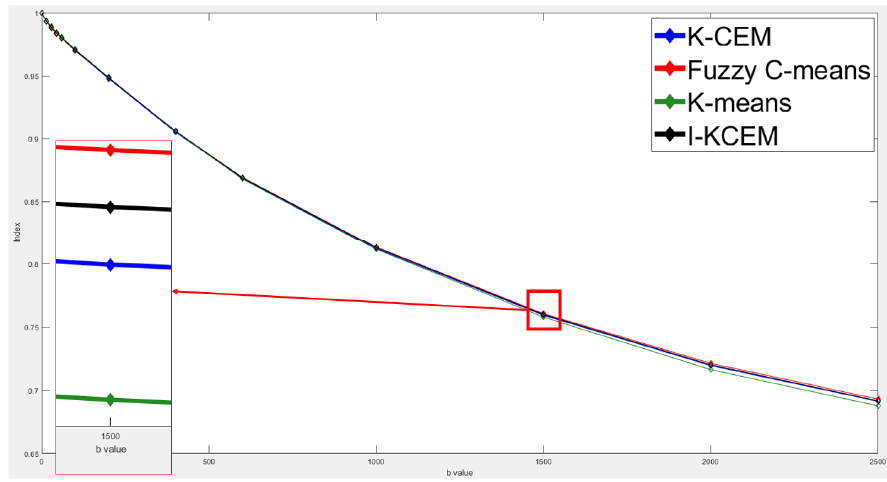
Figure 14. Signal-intensity decay of a fibroadenoma detected by the four methods using different b values in the 8th slice. Table 3 shows ADC, signal decay slope, D*, D, and PF parameter values for a fibroad- and I-KCEM. Table 3. Results of applying different detection methods to a fibroadenoma tumor.